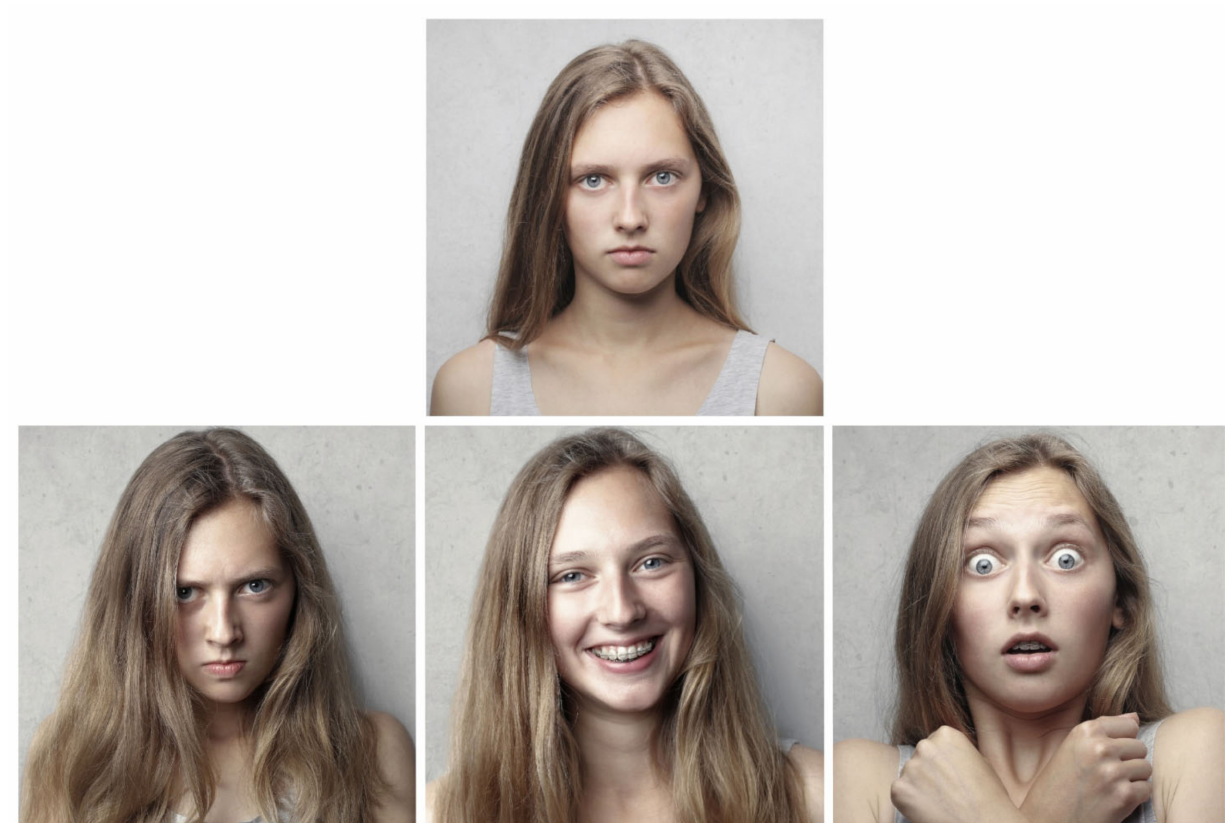
Figure 1. Emotional facial expressions of three basic, primary emotions. At the top is a neutral facial expression. In the bottom row, facial expressions of anger, joy, and fear are shown, respectively. Although individual emotions can be recognized and analyzed even from the microexpressions of facial muscles, for the sake of clarity the expressions of emotions in these photographs are accentuated. See text for details. Photographs by Andrea Piacquadio, taken from